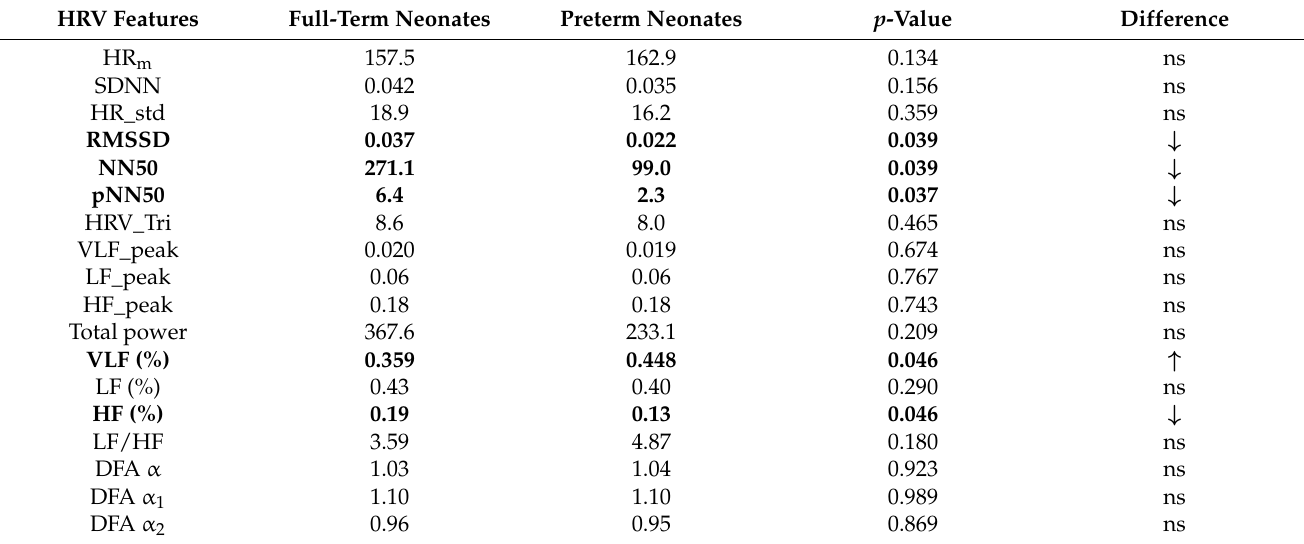
Table 4. Comparison of HRV parameters between full- and preterm infants for the whole recording duration.